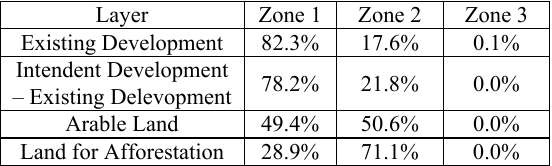
Table 2. Distribution of layers in